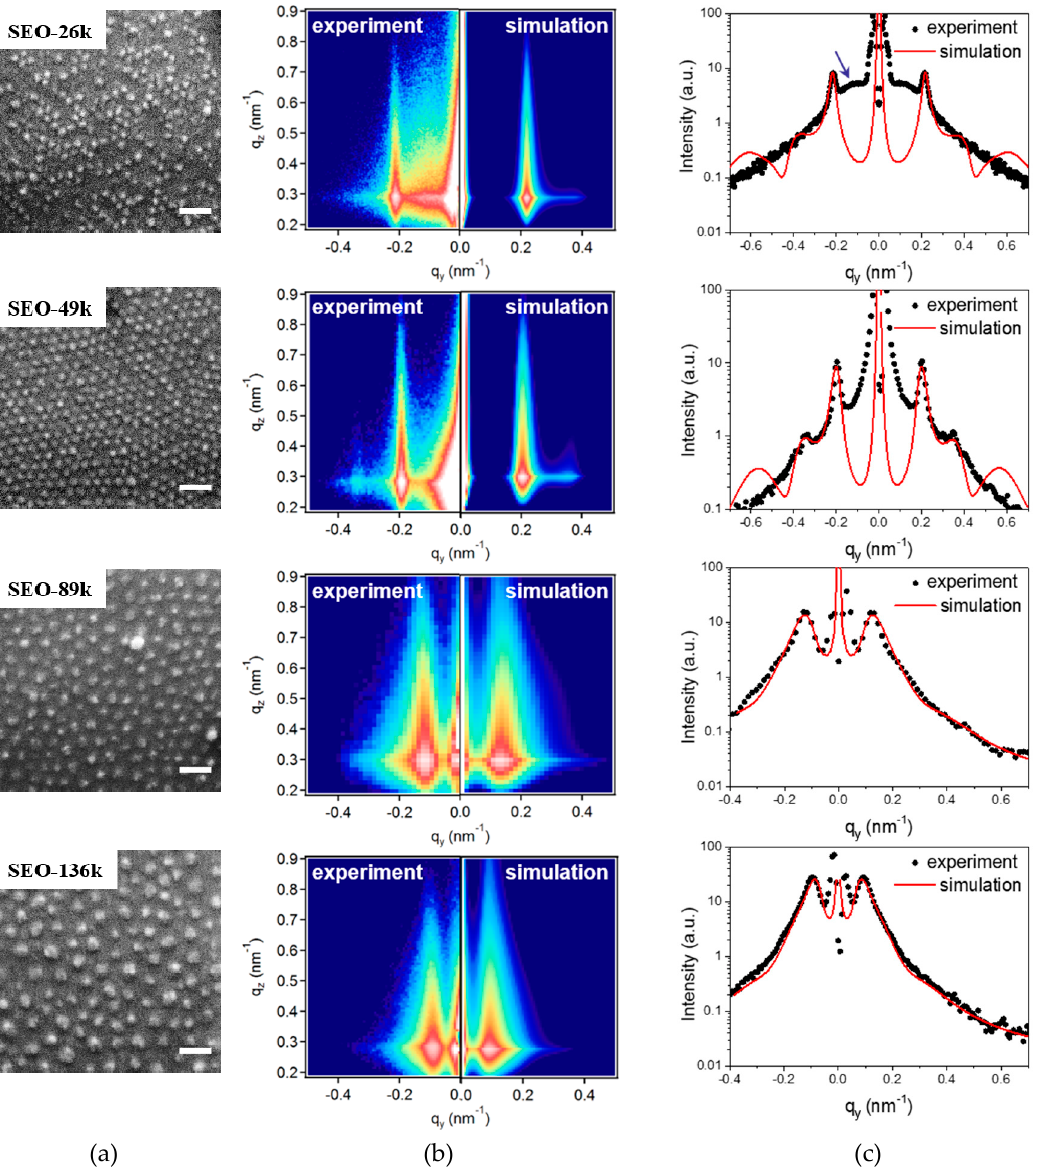
Figure 4. ( a ) SEM images from CFO nanodots (scale bar 100 nm). The text in the white boxes reports the BCP template name (Table 1) used to prepare the CFO dot assemblies. ( b ) The corresponding experimental and simulated 2D grazing incident small-angle X-ray scattering (GISAXS) patterns. ( c ) The corresponding 1D GISAXS patterns along the q y direction together with the best-fit curves in red. The blue arrow in the 1D pattern of SEO-26k is a visual aid for a broad di ff raction